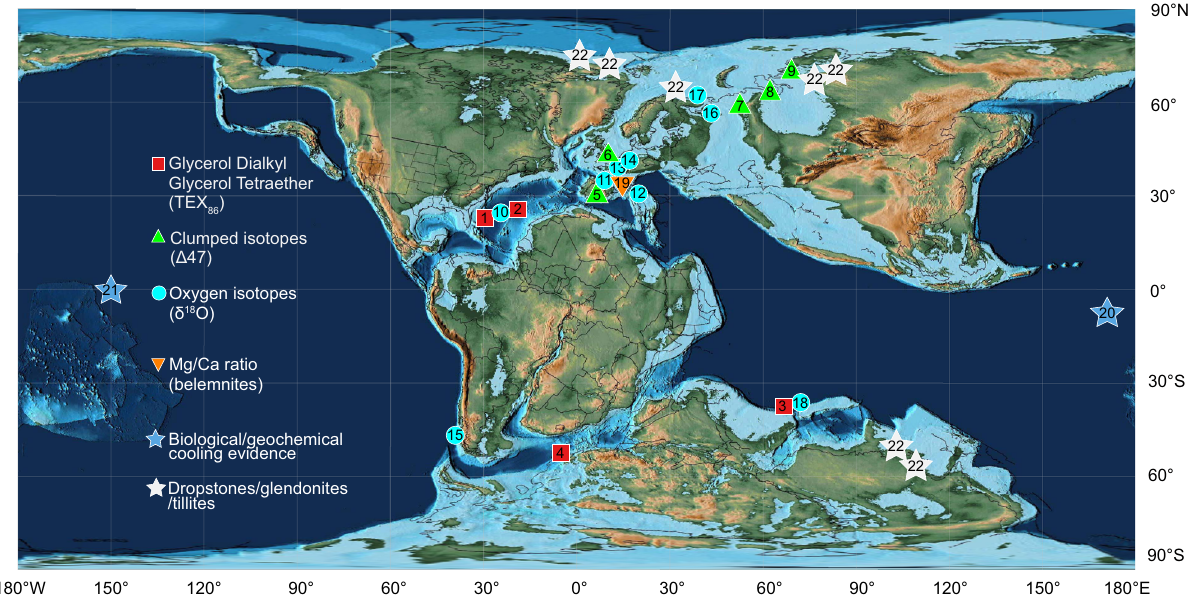
Fig. 1 Paleogeographic reconstruction of the Valanginian – Early Hauterivian (~133 Myr). Paleogeographic map by C.R. Scotese, PALEOMAP project 64 modi fi ed in this work to show the location of available Valanginian – Early Hauterivian multi-proxy-based temperature records (e.g. TEX 86 , oxygen carbonate clumped isotopes, oxygen isotopes and belemnite Mg/Ca ratios) from Deep Sea Drilling Project/Ocean Drilling Project (DSDP/ODP) Sites and other worldwide sections: (1) 534, (2) 603, and (3) 766 17 ; (4) 692 this study and 17 ; (5) Caravaca, (6) Speeton, (7) Izmha, (8) Yatria and (9) Boyarka 20 ; (10) Proto North Atlantic compilation 16 ; (11) South East (SE) France compilation 6,18 ; (12) Northwestern Tethys compilation 18 ; (13) Southern Boreal compilation 18 ; (17) Festningen and Janusfjellet 19 ; (18) 765 15 ; (19) Vocontian Trough compilation 15 . Biological and geochemical cooling evidence in sub-tropical oceans (blue stars) from calcareous nannofossils at (20) Site 1049 9 and from steryl ethers at (21) Site 1213 33 ; (22) compilation of Late Valanginian geologic cooling evidence in sub-polar regions (white stars) from dropstones, glendonites and tillites 16 . Red box symbols indicate TEX 86 data, green triangles clumped isotopes, turquoise circles oxygen isotopes, orange down-pointing triangles Mg/Ca ratio